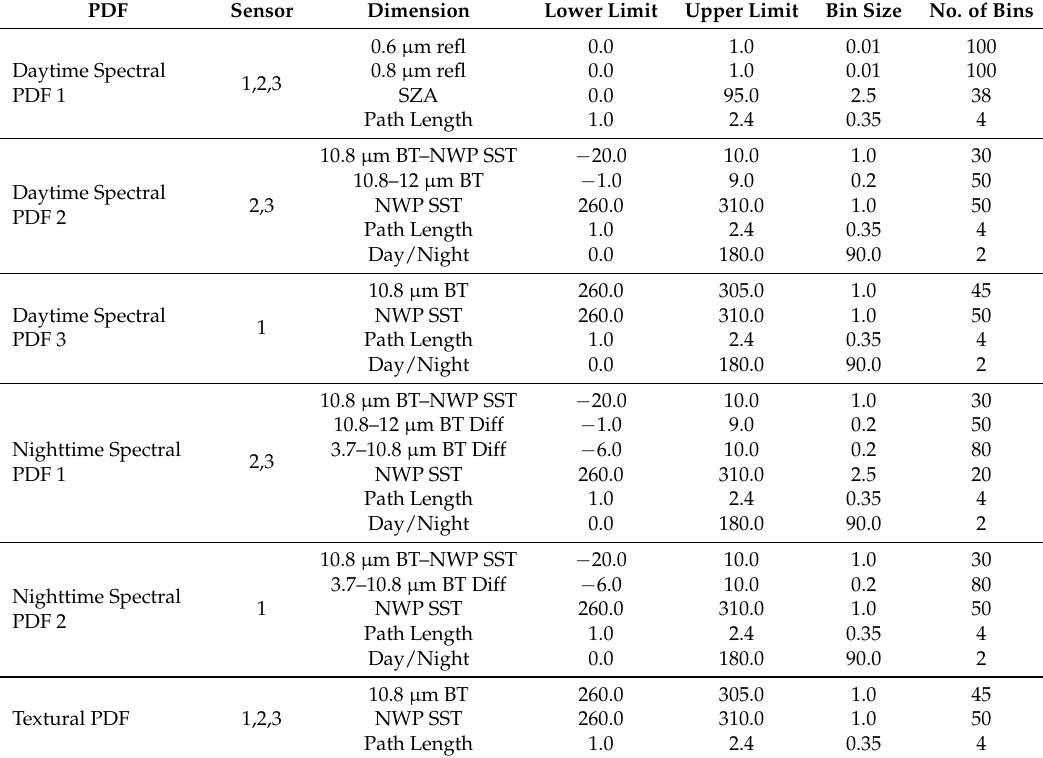
Table 2. Empirical cloudy PDF specifications as applied for AVHRR cloud detection. Acronyms used are as follows: BT - brightness temperature, NWP - numerical weather prediction, SST - sea surface temperature, Diff - difference, SZA - solar zenith